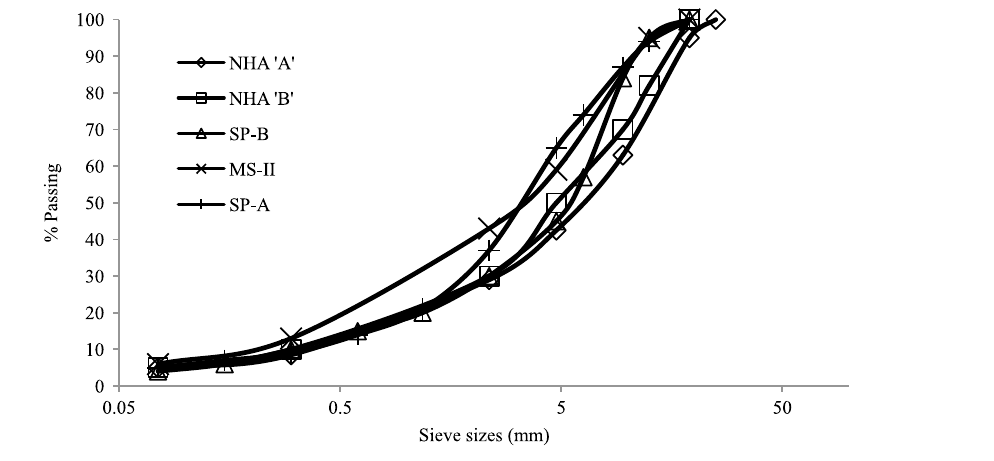
FIG. 2. CENTERLINE GRADATIONS CURVES OF ASPHALTIC WEARING